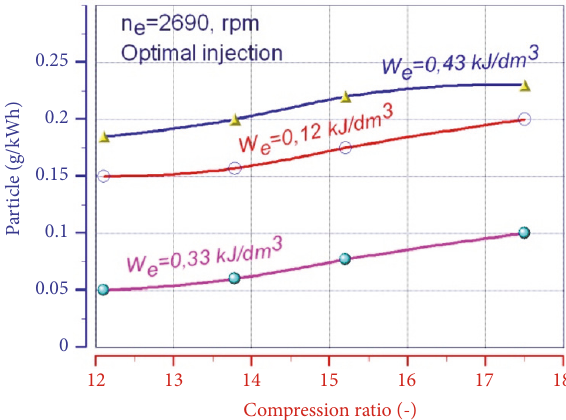
Figure 9: Selection of the optimal value of the (CR) for the engine operation with minimal fuel consumption.